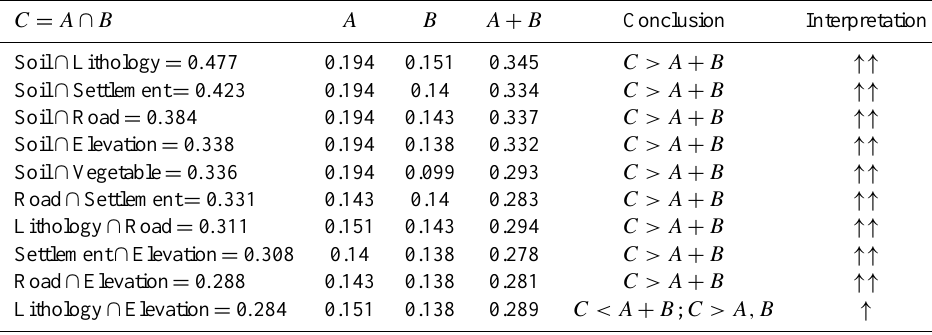
Table 7. Interaction between pairs of driving factors influencing the KRD deterioration. C = A ∩ B A B A + B Soil ∩ Lithology = 0 . 477 0.194 0.151 0.345 ↑↑ Soil ∩ Settlement = 0 . 423 0.194 0.14 0.334 C > A + B ↑↑ Soil ∩ Road = 0 . 384 0.194 0.143 0.337 ↑↑ Soil ∩ Elevation = 0 . 338 0.194 0.332 Soil ∩ Vegetable = 0 . 336 ↑↑ Road ∩ Settlement = 0 . 331 0.143 0.14 0.283 Lithology ∩ Road = 0 . 311 0.151 Settlement ∩ Elevation = 0 .